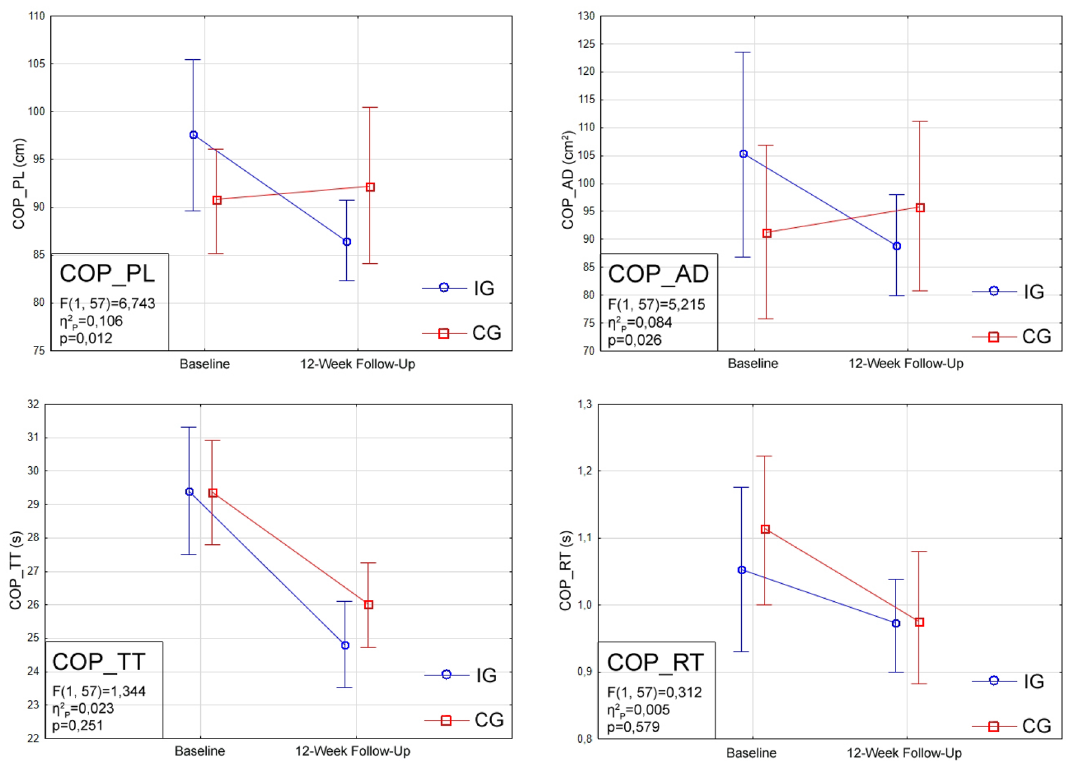
Figure 3. Pre- and postintervention static balance results for Centre of Pressure Path Length (COP_PL), Centre of Pressure Deviation Area Deviation (COP_AD), Centre of Pressure Total Time (COP_TT) and Centre of Pressure Reaction Time